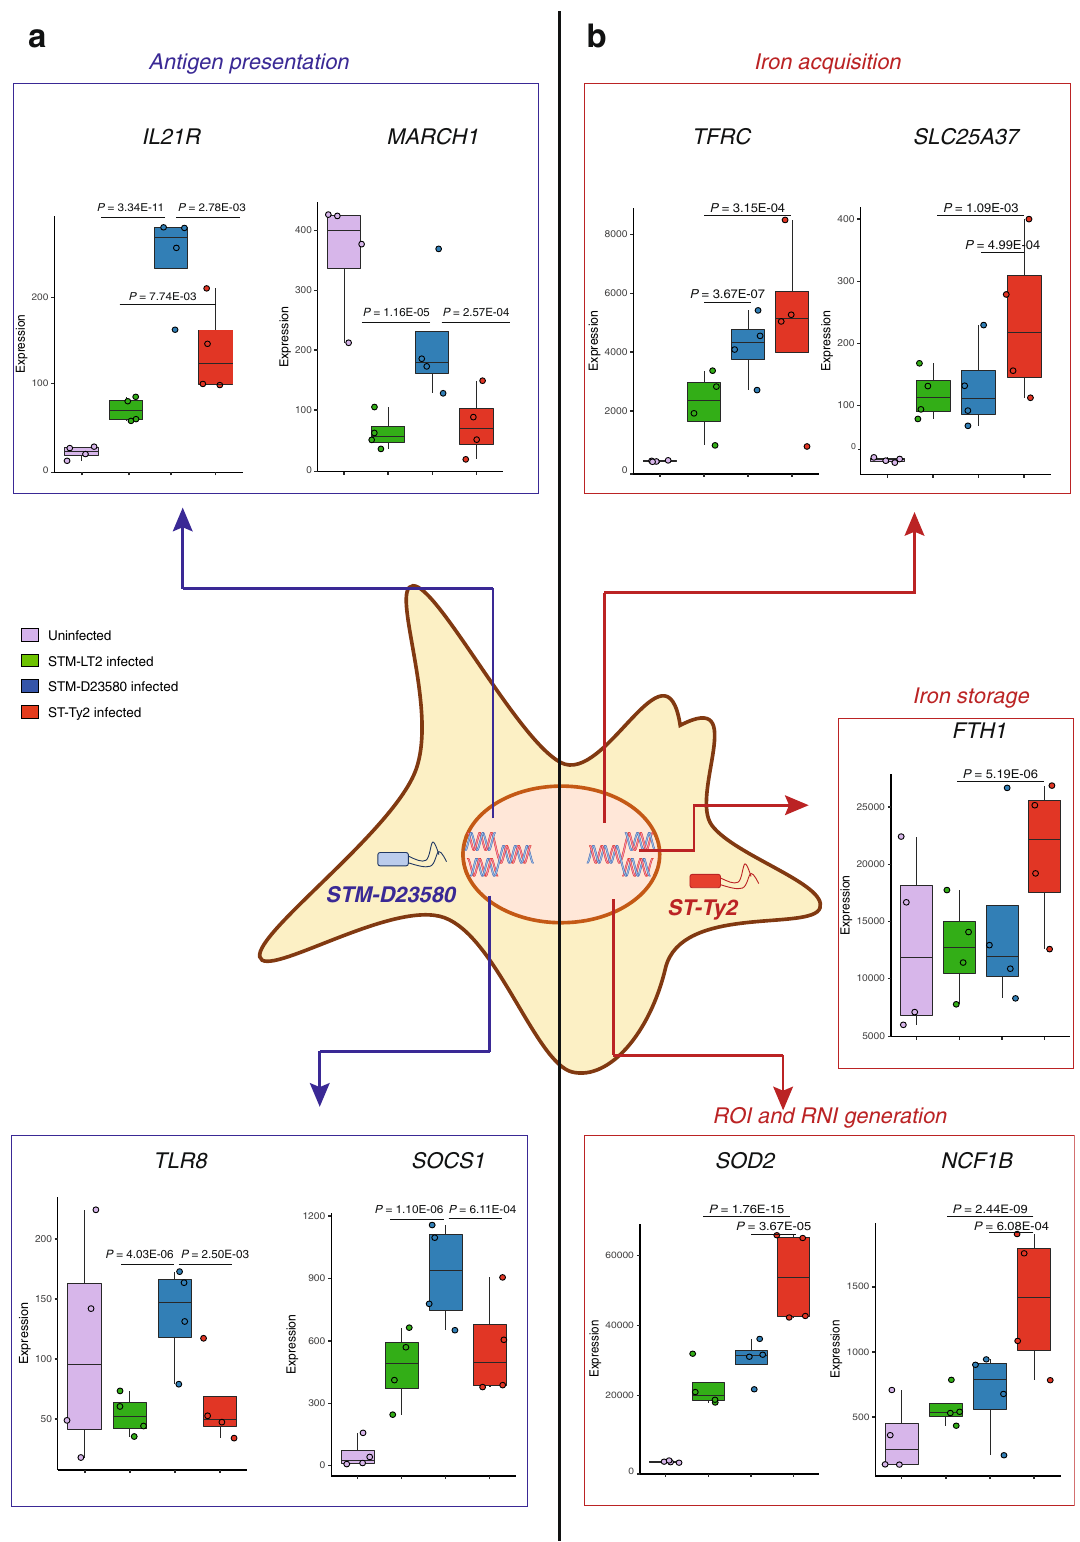
Fig. 3 Unique host response to invasive Salmonella . a Box plots displaying the normalised gene expression level of MARCH1, IL21R, TLR8, SOCS1 in infected and uninfected cells. b Box plot displaying the normalised gene expression level of relevant DE genes identi fi ed between ST-Ty2-infected cells and S . Typhimurium-infected or uninfected